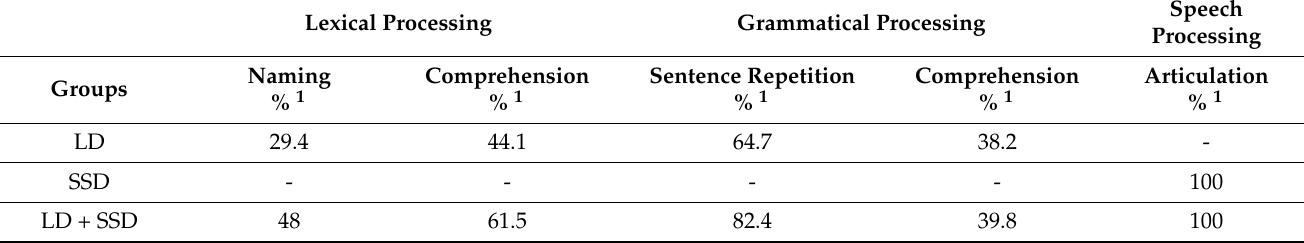
Table 2. Percentages of children with LD, SSD, LD + SSD who obtained clinical scores in Naming, Comprehension, Sentence Repetition, Comprehension, and Articulation subtests.